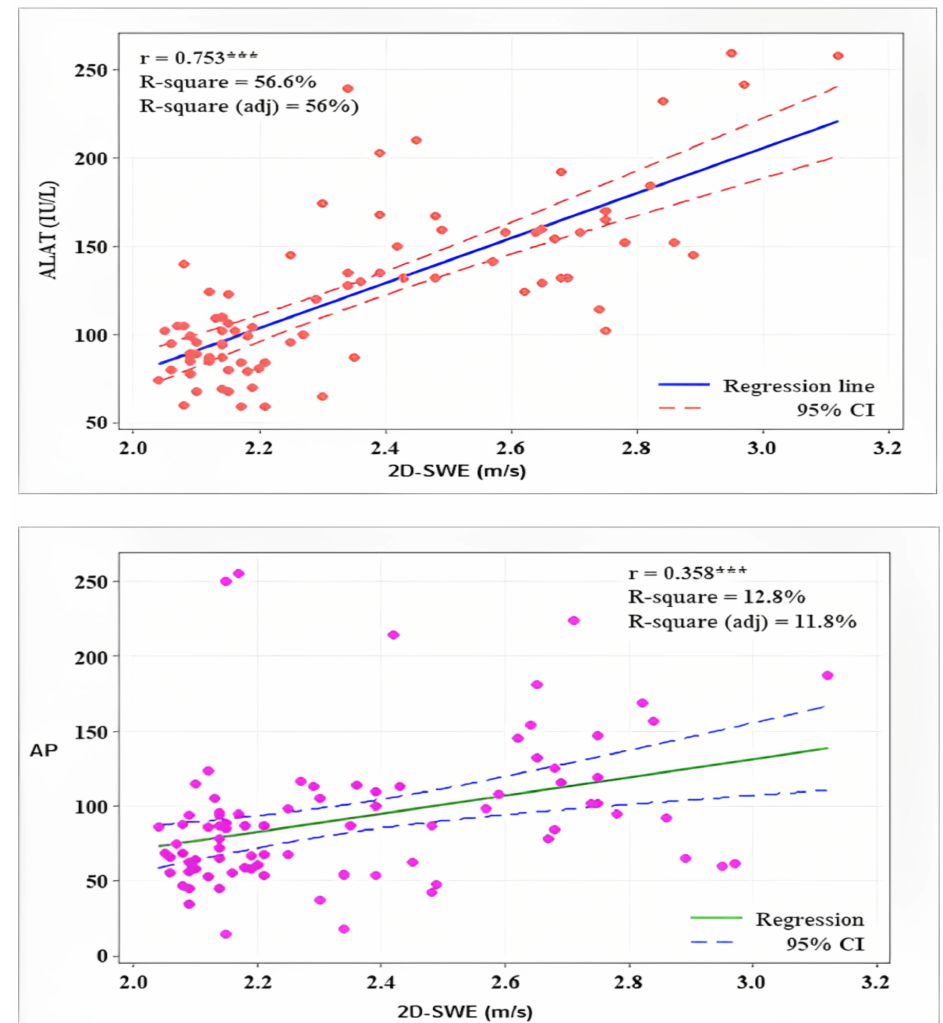
Figure 3. Correlation between liver 2D-SWE and biochemical blood indicators ASAT, ALAT, and alkaline phosphatase. ***—Significant assossiation ( p < 0.001); r—Pearson’s correlation coefficient; R-suqare—coefficient of